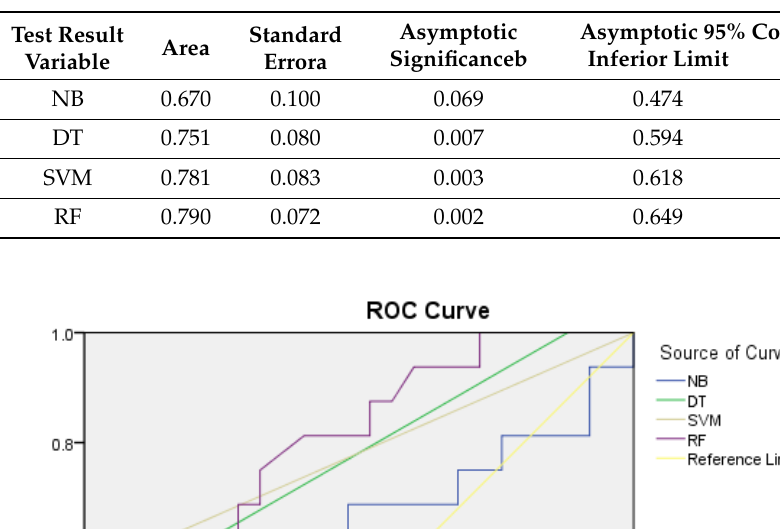
Table 8. Result of AUC.